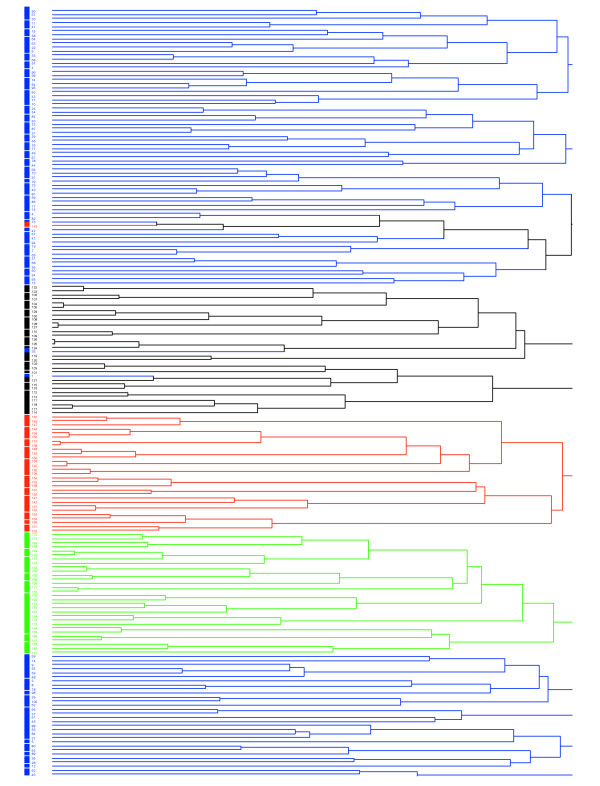
Hierarchical cluster plot of simulation with two genotypes, 100 noise genes, and three factors. ρ = 0.40, effect size = 0.2, 0.4, and 0.6. Blue, noise genes; green, genes from underlying factor 1; red, genes from underlying factor 2; black, genes from underlying factor 3.